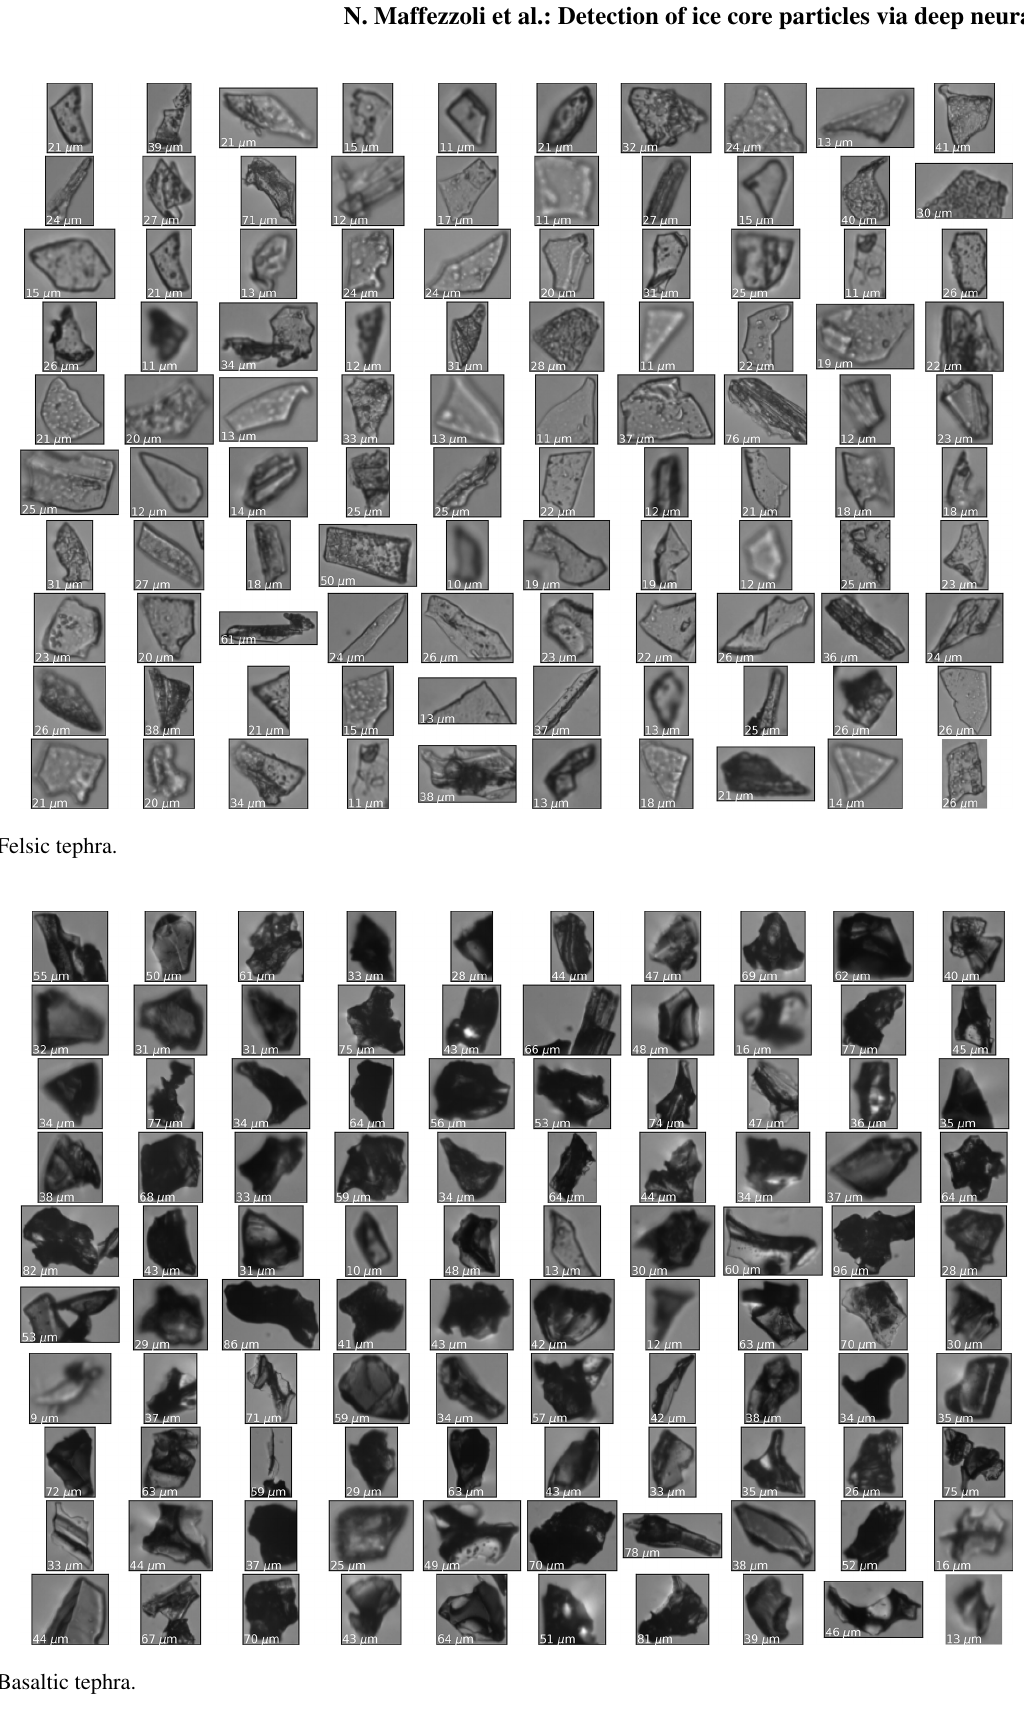
The Cryosphere, 17, 539–565,